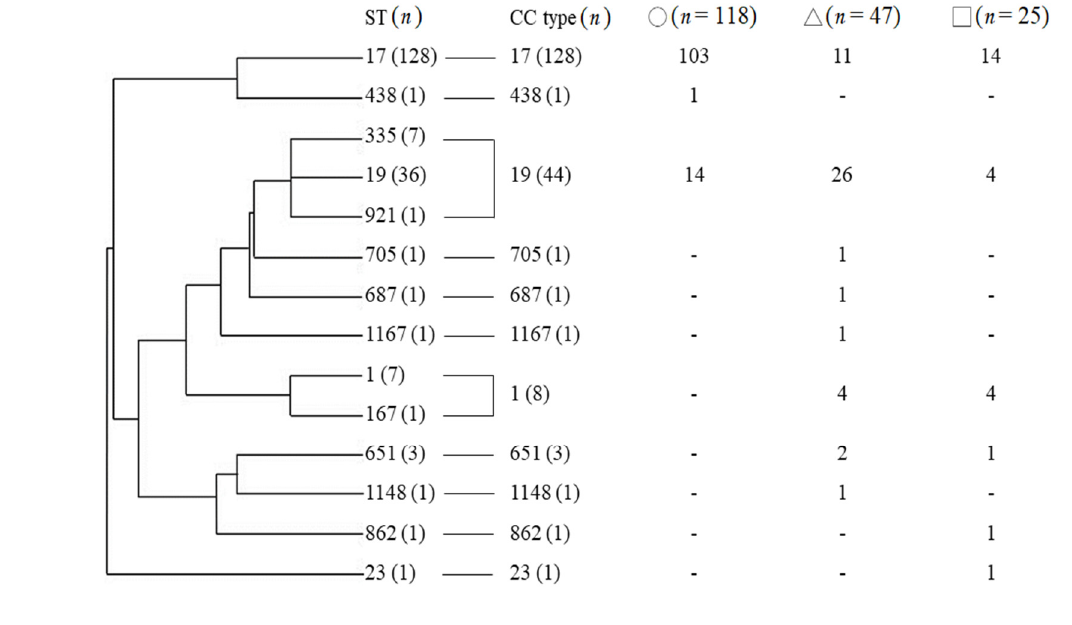
Figure 1. Phylogeny of the 190 type III GBS isolates from neonates and adults with invasive GBS diseases and colonized pregnant women. Distributions of sequence types and clonal complexes from different sources are presented; - means zero.